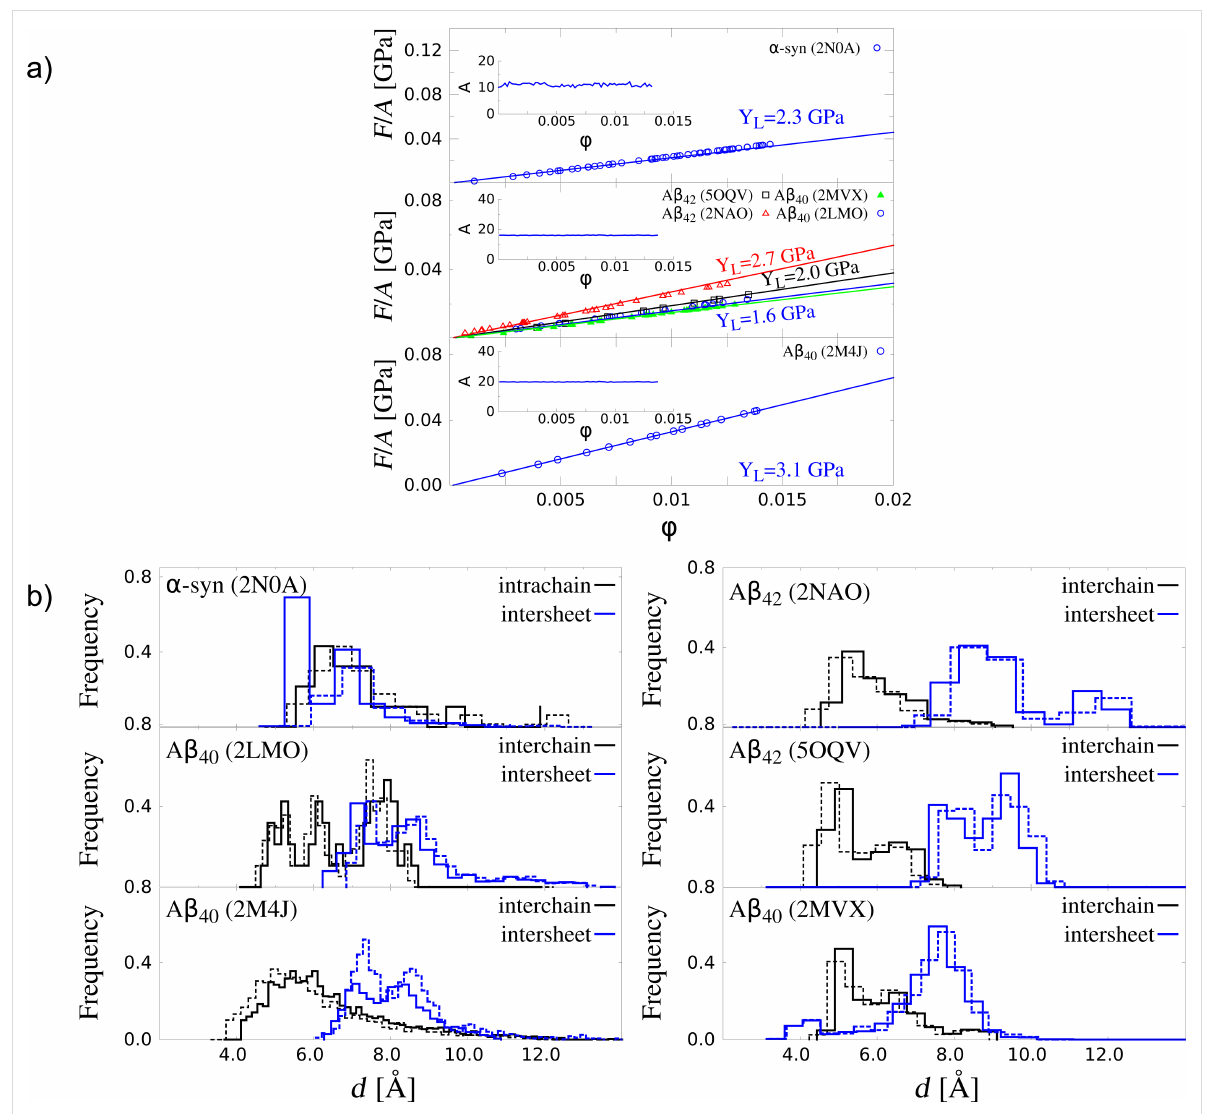
Figure 4: Results of tensile deformation. (a) Stress–strain curves of α -synuclein, three A β 40 and two A β 42 fibrils. Circles correspond to v = 0.0005 Å/ τ . The error bars are the same as the symbol size and they are based on 50 independent simulations for each structure. The insets show the corre- sponding cross-section areas in nm 2 for the corresponding pulling speed. (b) Distributions of HB lengths for (solid lines) and for a finite strain corresponding to the end of the linear regime (dashed lines): for α -syn the final , while for A β